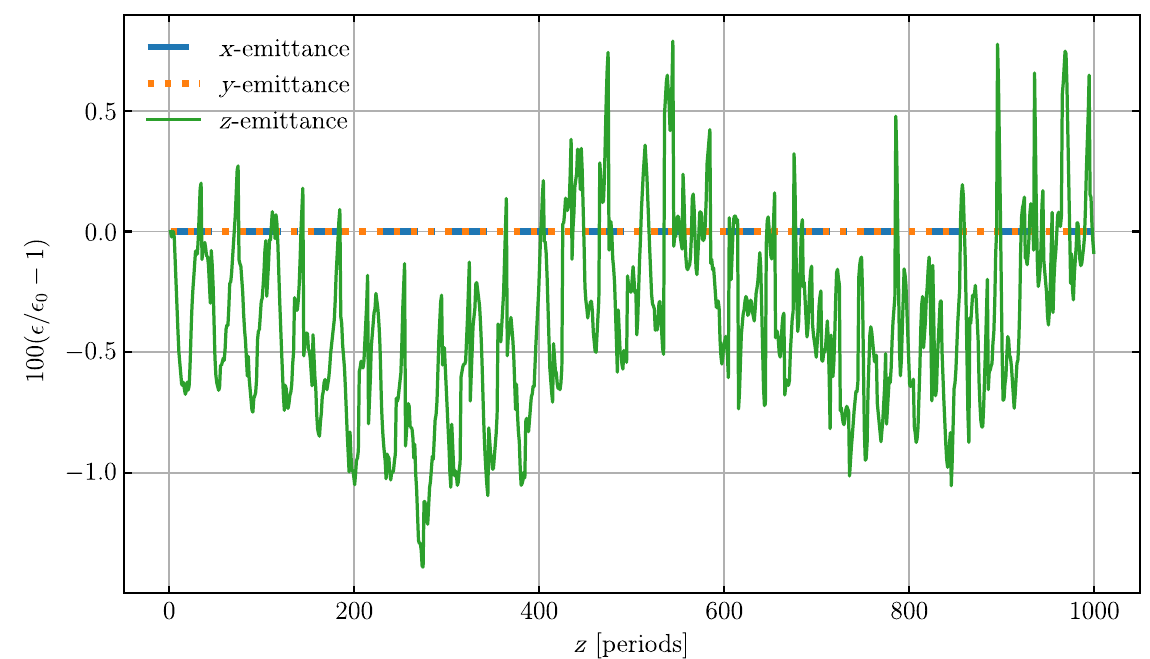
FIG. 4. The relative growth of the 4 rms emittance of a beam in a long focusing channel simulated in HYPER 3 D